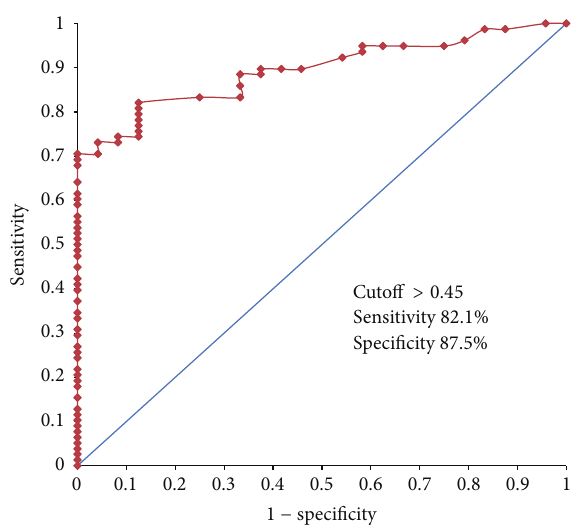
Figure 1: ROC curve for urine protein :creatinine ratio to predict proteinuria of 300 mg/24